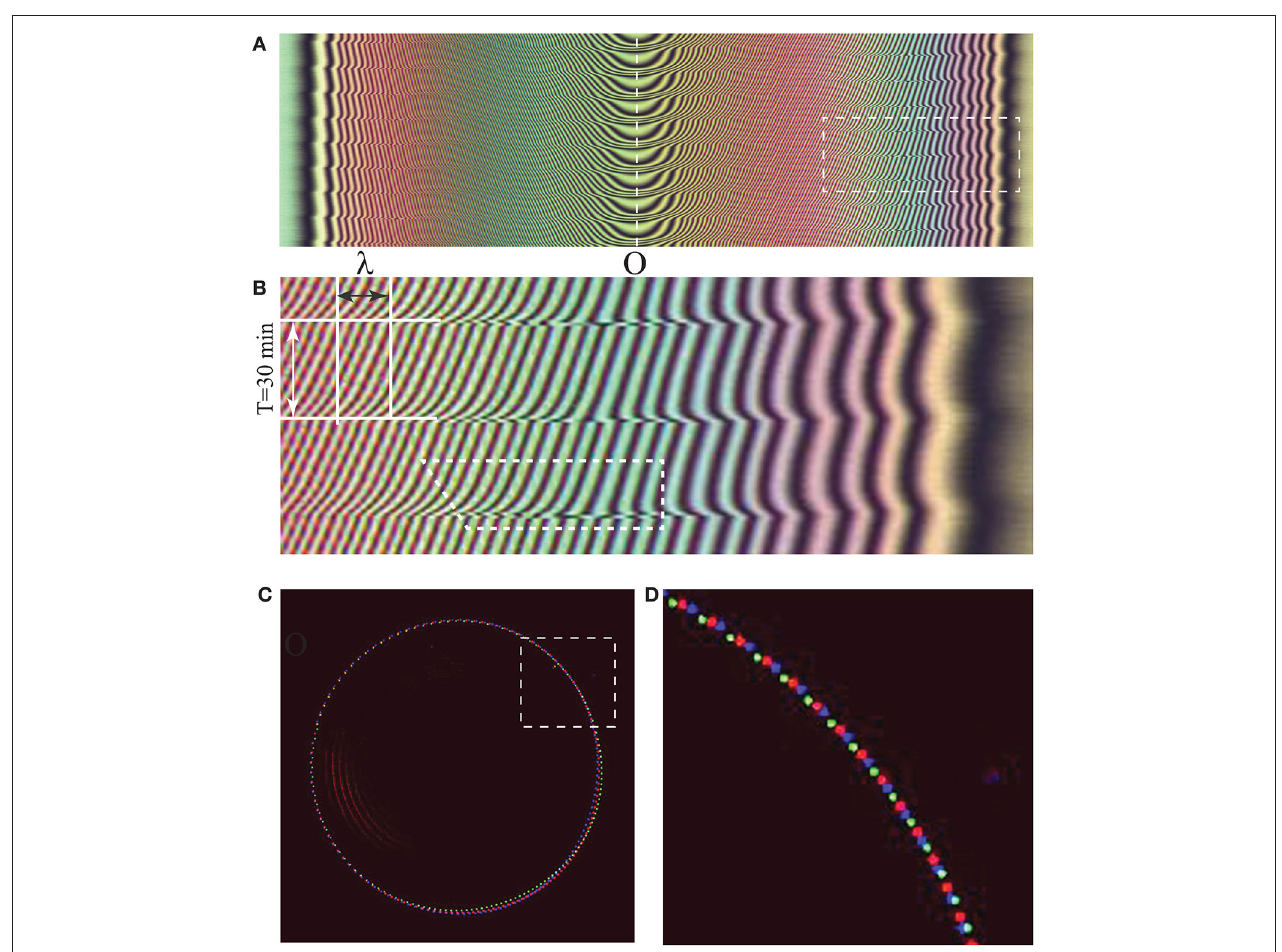
FIGURE 9 | Cladis-Brand [11] dynamically stable state C-B1 of the phase winding in the Circular Dowsons’ Collider. (A) Spatio-temporal cross section taken along the dashed line defined in Figure 8F . Four new isogyres are nucleated at the center O during one period T of the orbiting motion of the dowson d + . (B) Blow up of the rectangular domain defined with a dashed line in (A) . λ is the width of a 2 π wall composed of four oblique trajectories of isogyres. During one period T = 30 min, the 2 π wall is shifted by λ to the right. (C) Successive positions of the dowson d + recorded as colored dots at intervals of 10 s during three periods of its orbital motion. The three colors of dots correspond to the three periods T of the orbital motion. (D) Blow up of the rectangular domain defined with dashed line in (C) .